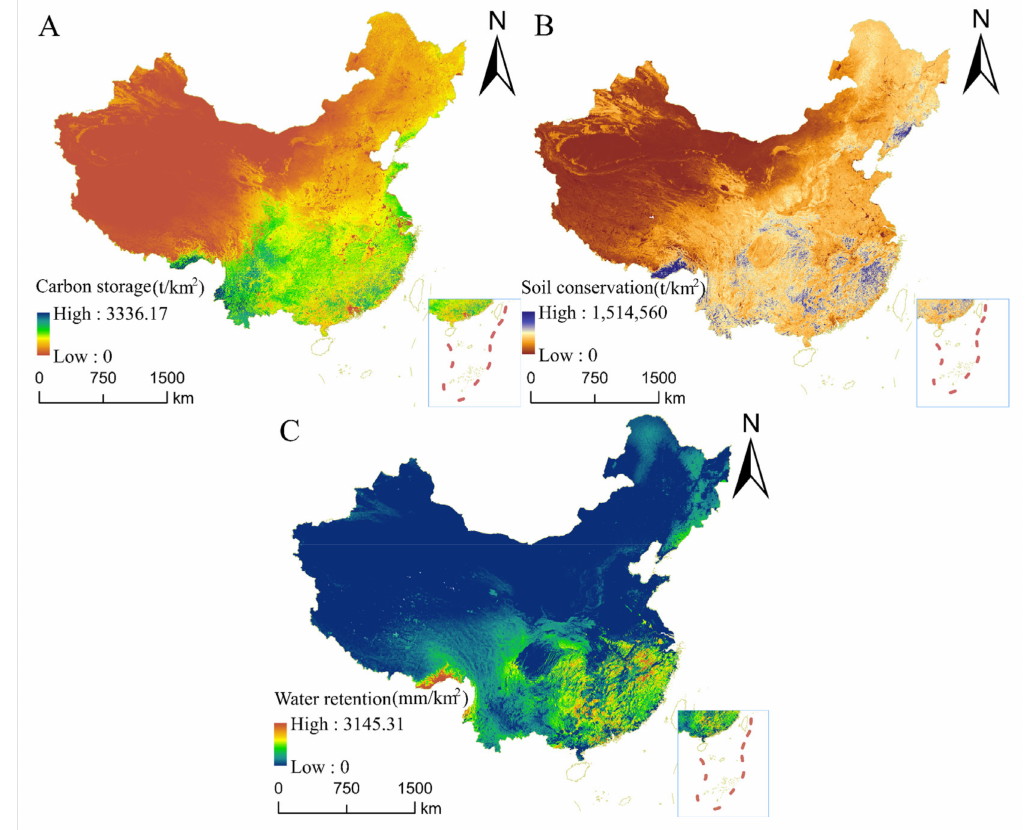
Figure 7. Carbon storage ( A ), soil conservation ( B ), and water retention ( C ) in the study